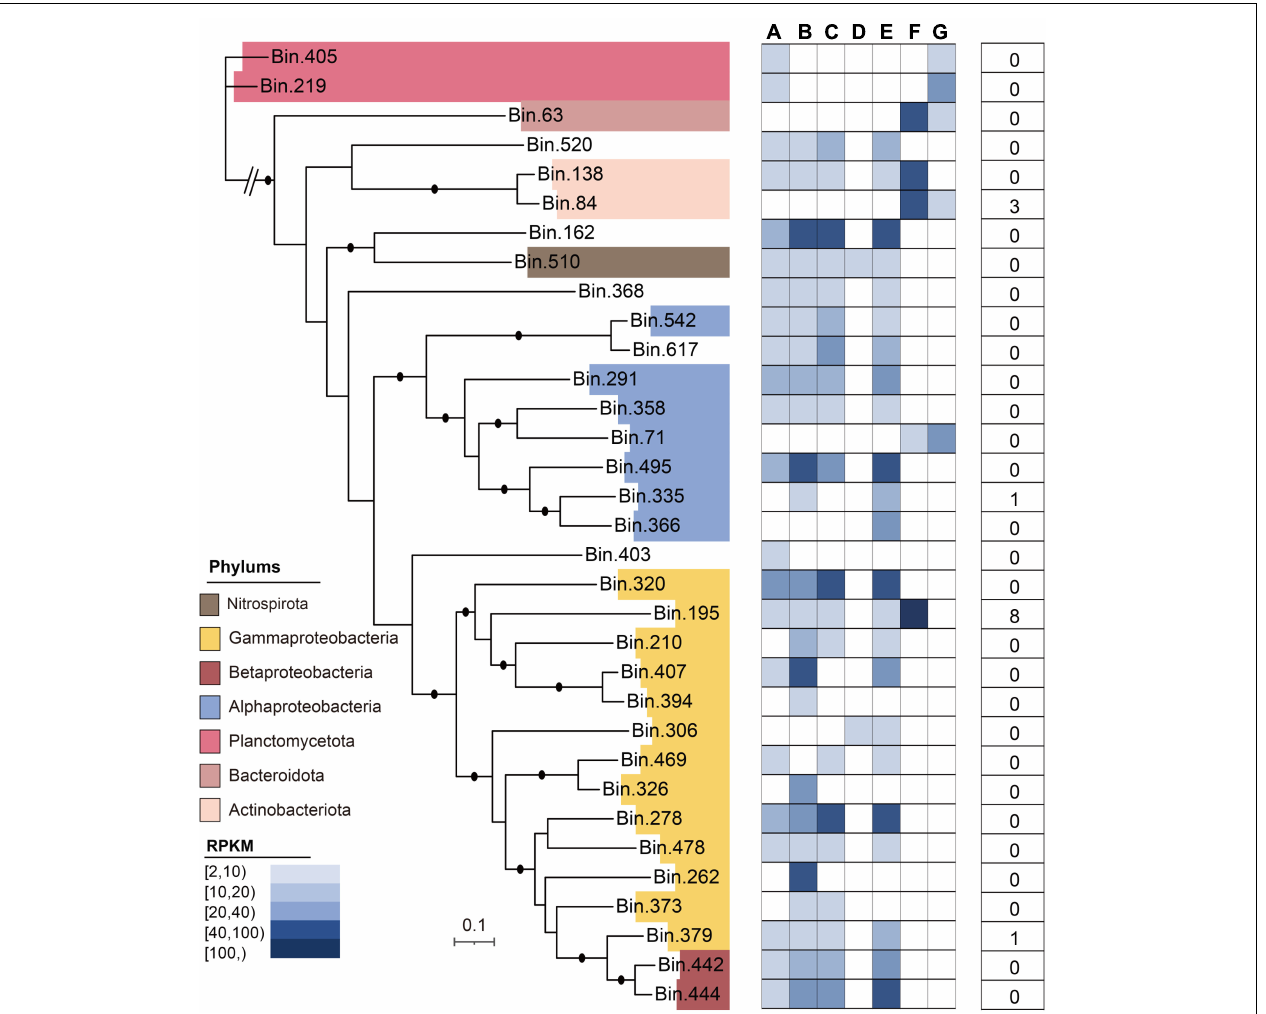
FIGURE 7 | Taxonomic assignment of 33 MAGs reconstructed from the DWTS. The phylogenomic tree was constructed using 31 commonly conserved protein-coding genes. The average relative abundances [in reads per kilobase per million (RPKM)] of all MAGs in drinking water production processes are shown as a heat map, followed by data indicating the presence of the total ARG subtype numbers in